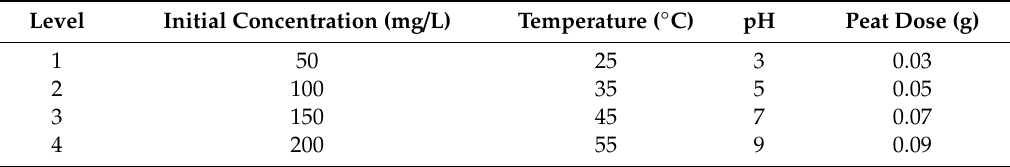
Table 1. Factors and levels of L16(44)